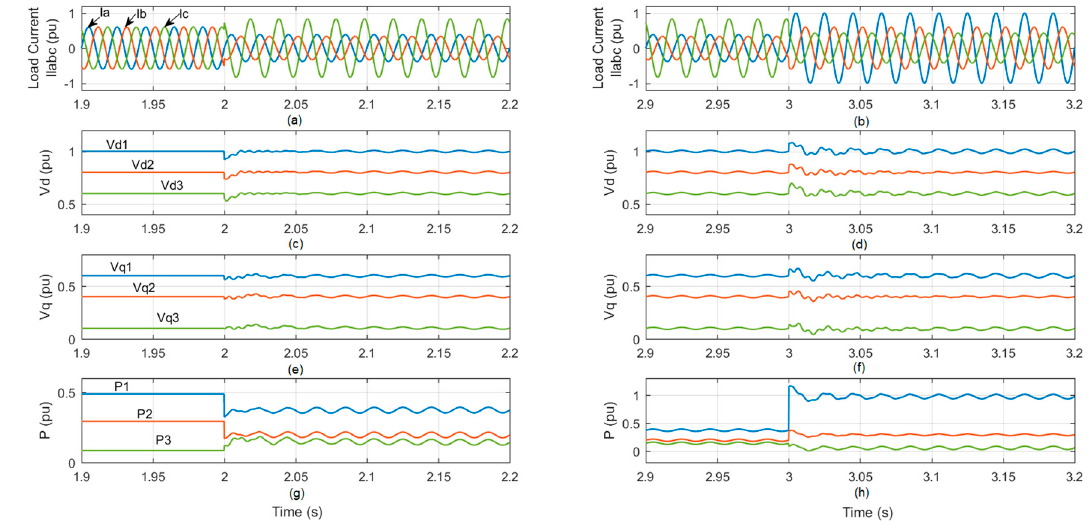
Table 3. Comparison with the control in [20]. Reproduced from [20], the name of the publisher: IEEE Trans. Power Deliv.